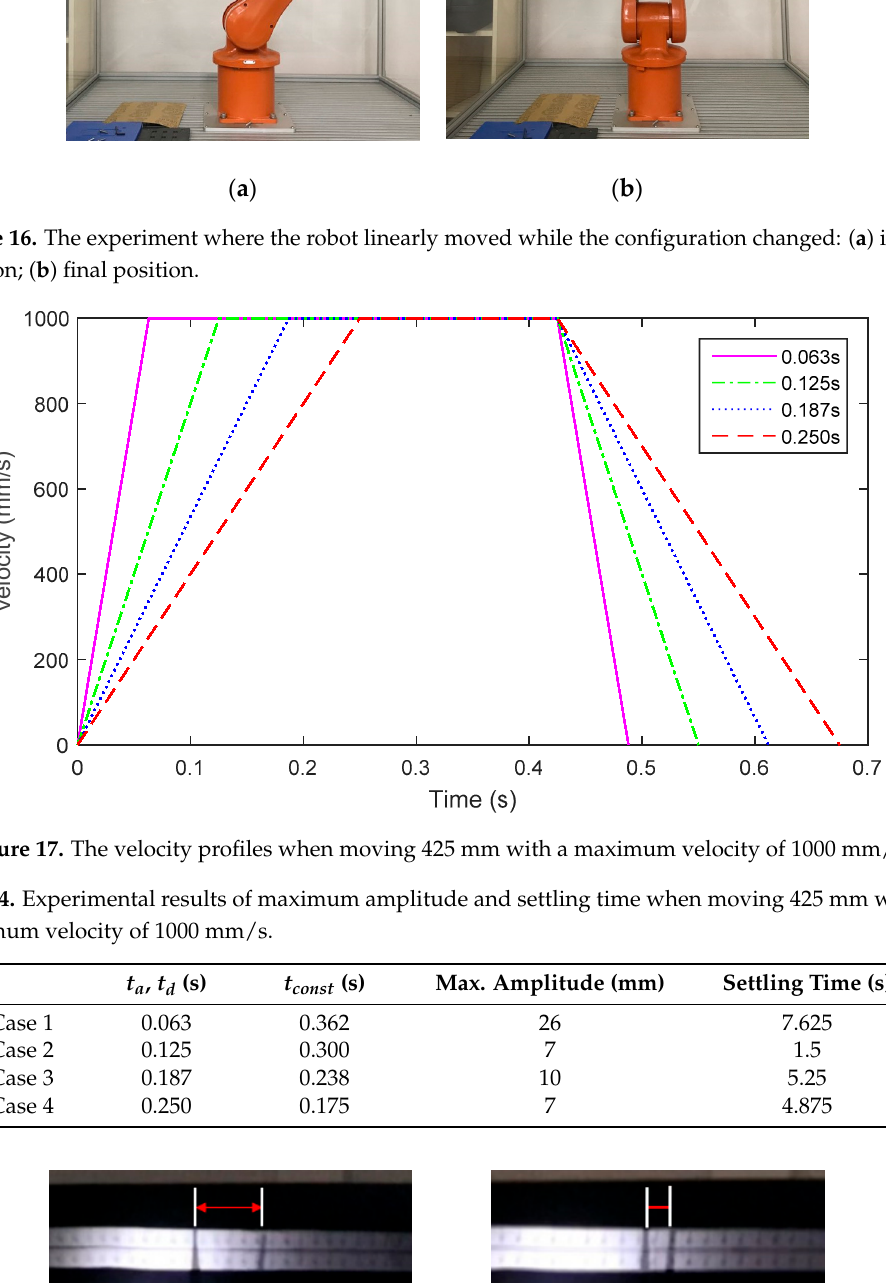
Figure 18. Position deviations at target: ( a ) when 𝑡 (cid:3028) = 0.063 ; ( b ) when 𝑡 (cid:3028) = 0.250 .